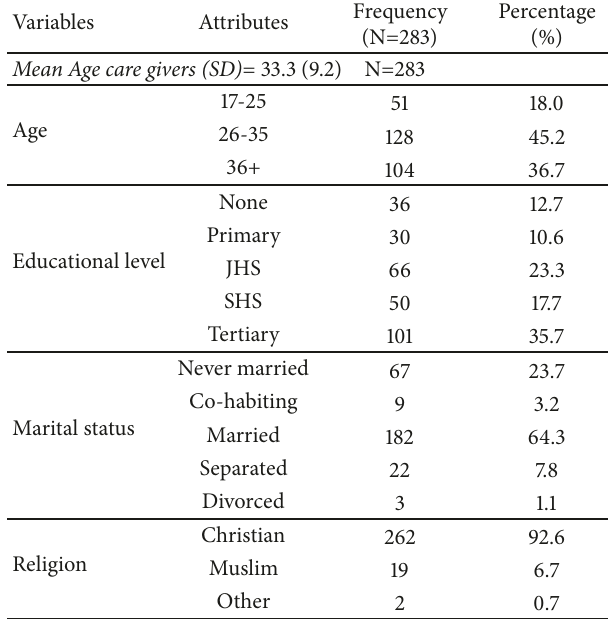
Table 1: Socio-demographic characteristics of respondents. Variables